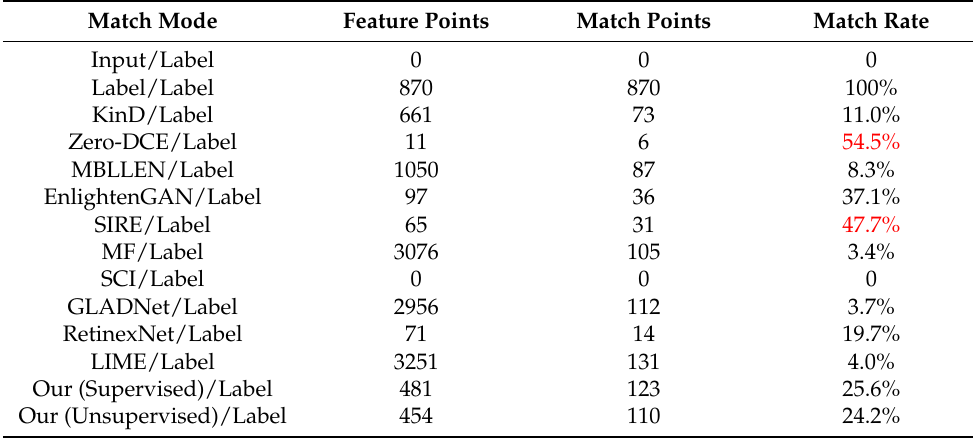
Table 5. Comparison of image matching results enhanced by different algorithms.